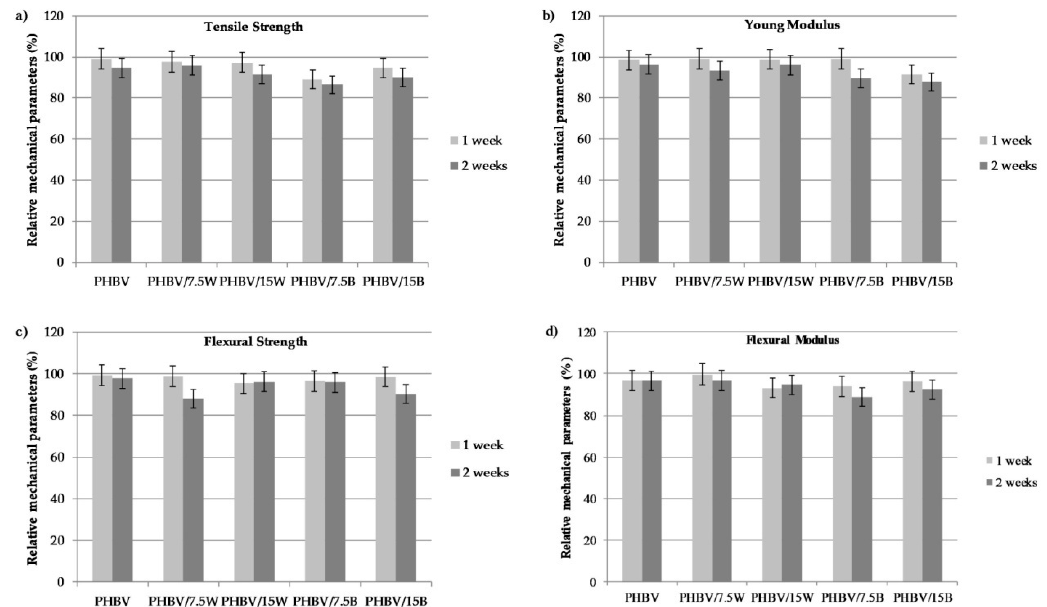
Figure 7. Relative percentage values of strength and modulus versus the initial composites for biodegraded samples.